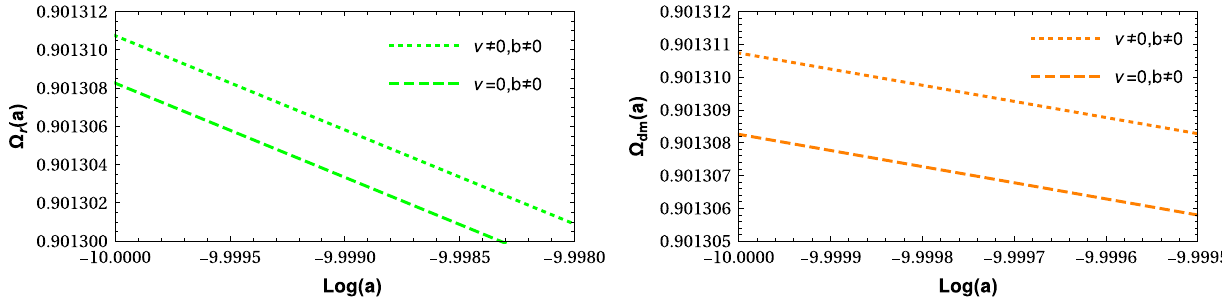
Fig. 2 The relative densities for usual (baryonic) matter and DM, described by RRG. There is a very small difference at the primordial epoch, compared to the (cid:3) CDM model. This difference does not affect the BBN